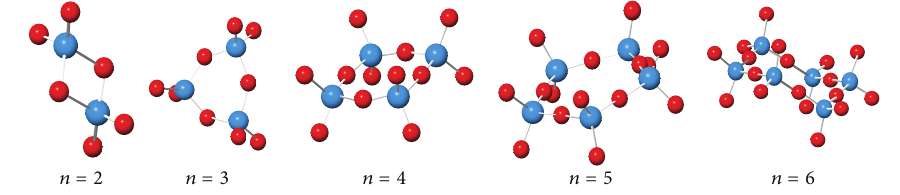
Figure 1: Optimized structures of the cyclic clusters of ( WO 3 ) 𝑛